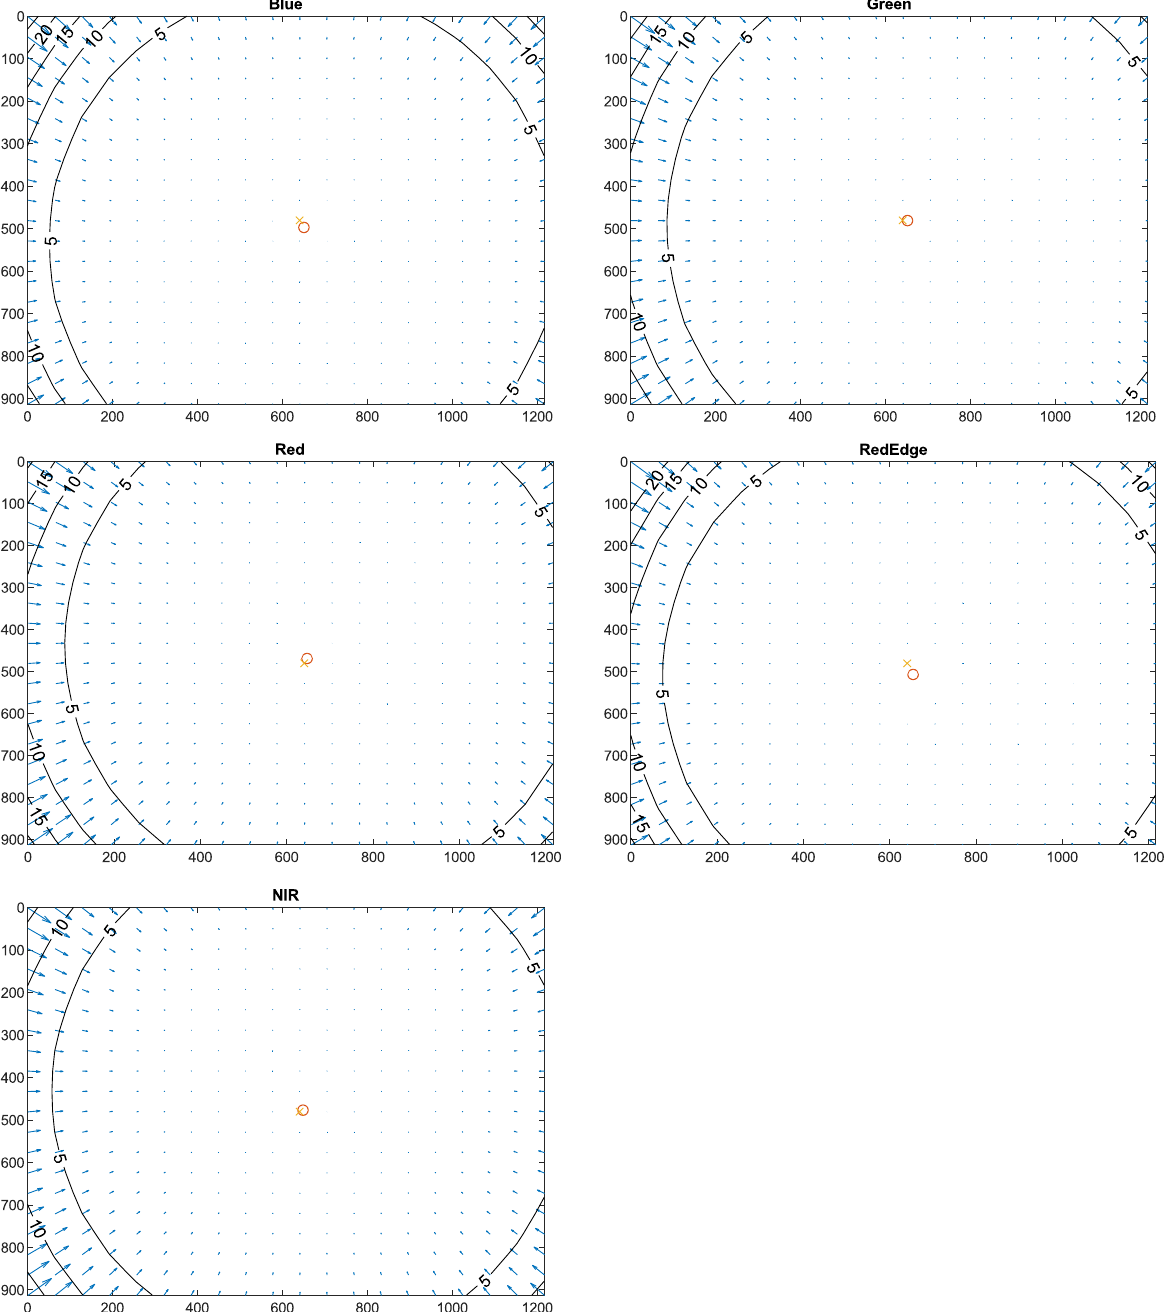
Figure 11. Geometric distortion of the five bands of the multispectral camera. The orange cross indicates the image center. The red circle indicates the principal point. Contour lines indicate distortion in pixels. Arrows indicate the magnitude and direction of the